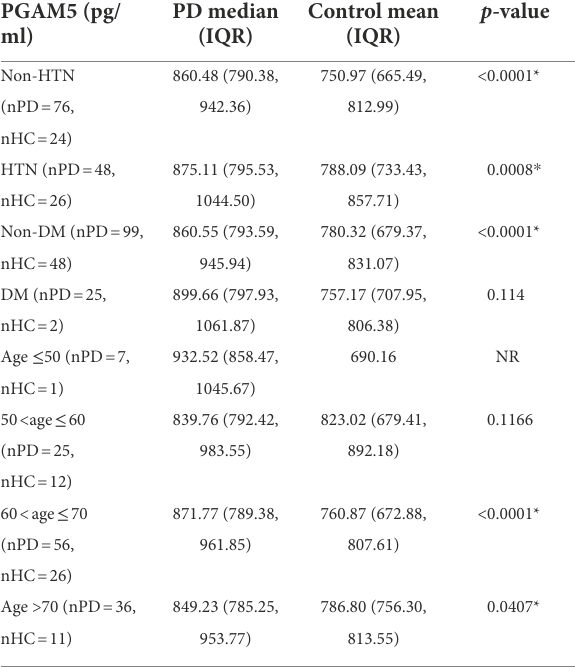
TABLE 2 PGAM5 levels in subgroups of hypertension (HTN), diabetes mellitus (DM), and age. PGAM5 (pg/